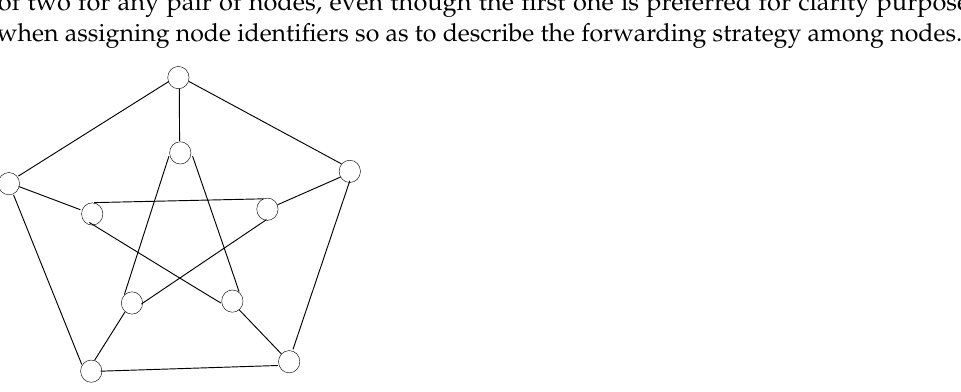
Figure 1. Petersen graph as a combination of a regular pentagon and a pentagonal star.